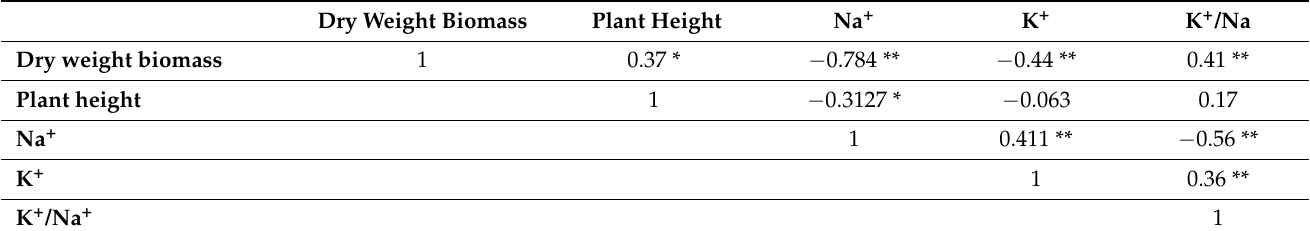
Table 3. The correlation coefficient between plant dry weight biomass, plant height, Na + , K + , and K + /Na + in Ae. tauschii populations (40) under salinity stress condition (200 mM